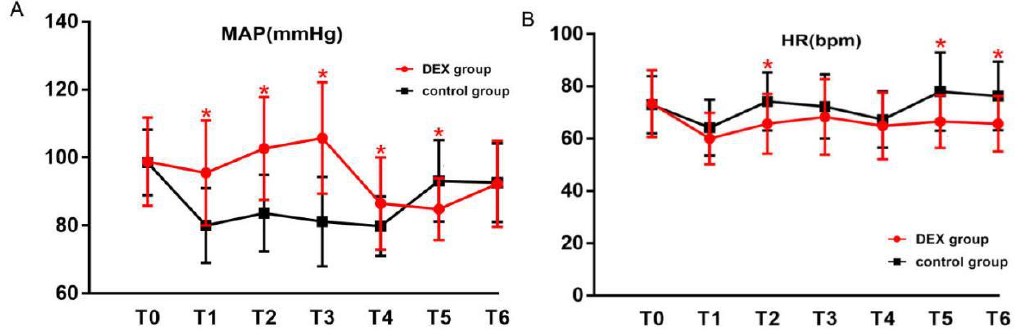
Figure 3. MAP ( A ) and HR ( B ) changes during the observable period. Values are present as mean ± SD. MAP, mean artery pressure; HR, heart rate; T0, before induction; T1, 1 min after induction; T2, at intubation; T3, at 5 min after intubation; T4, at the end of the procedure; T5, extubation; T6, 5 min after extubation. * p < 0.05, intergroup comparisons.